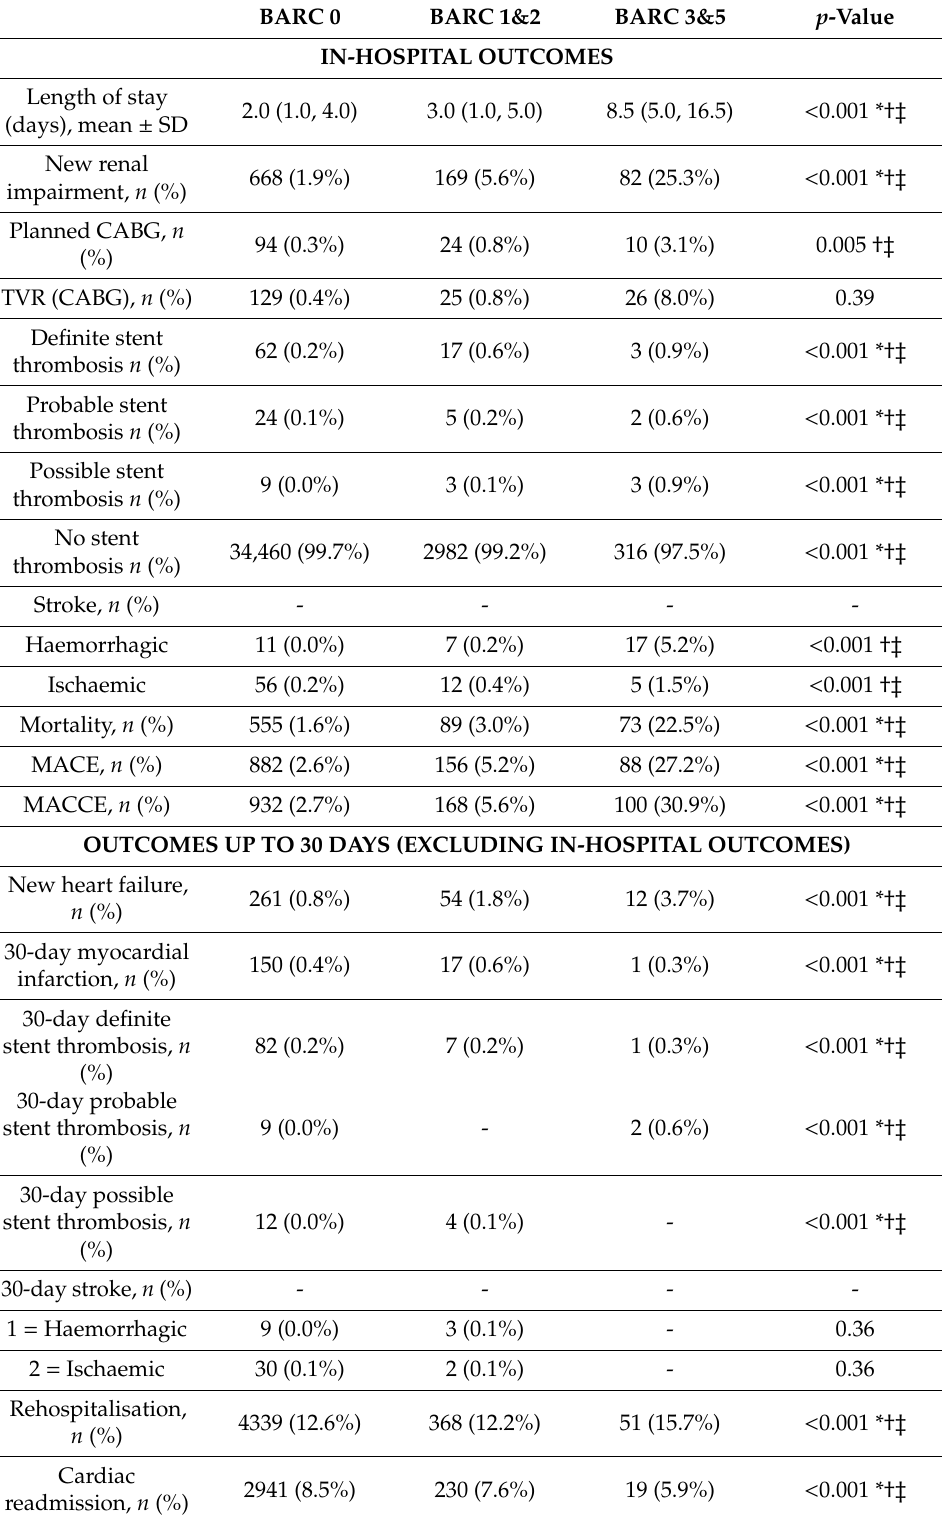
Table 3. In-hospital outcomes and outcomes up to 30